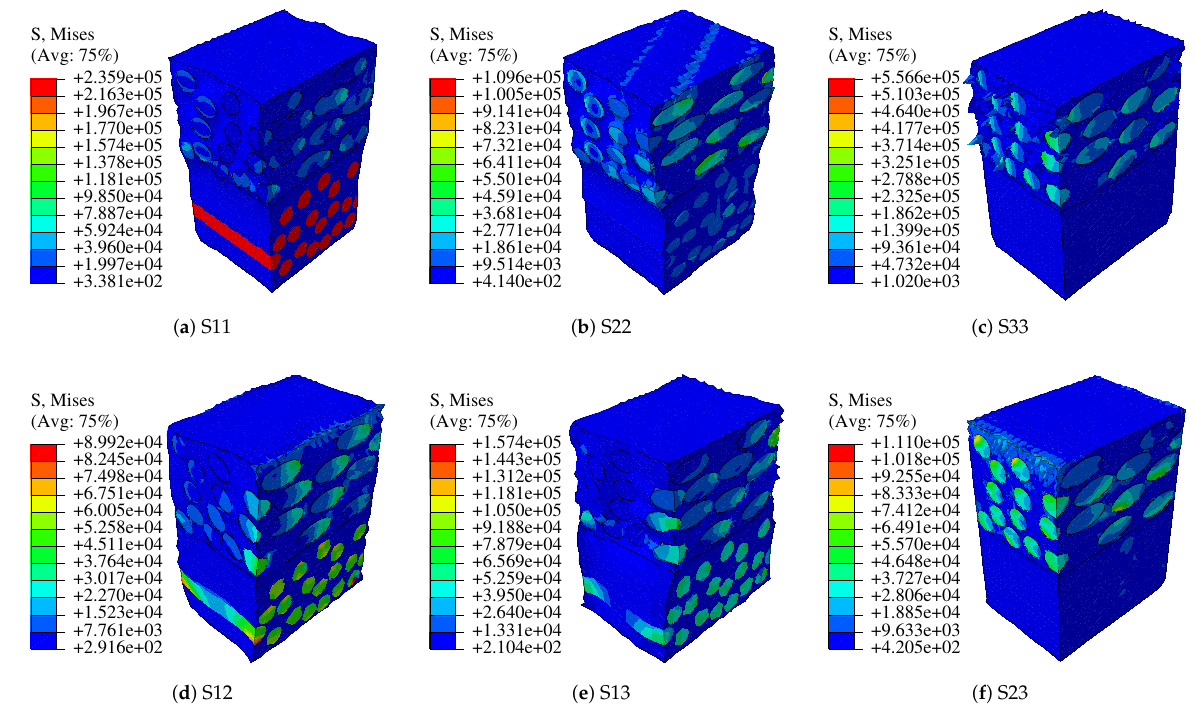
Figure 8. Characteristic stress diagram of mesoscopic model.